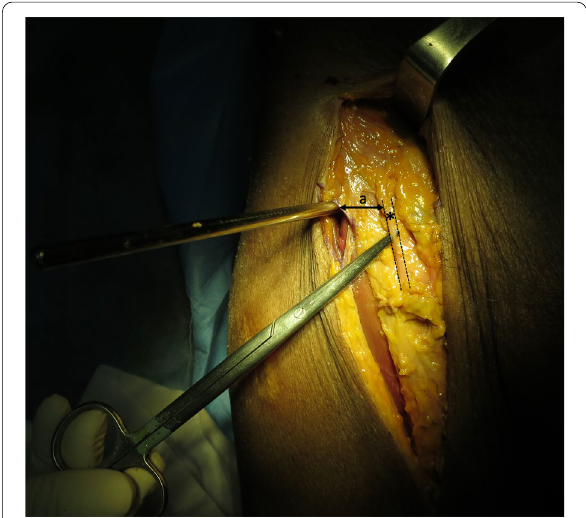
Fig. 5 The lateral femoral cutaneous nerve (LFCN) is identified ( asterisk ) medial to the pin on the right hemipelvis, and the distance ( a ) from the pin to the lateral femoral cutaneous nerve (LFCN)